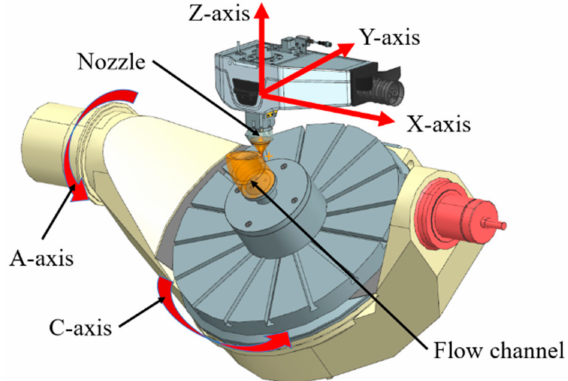
Figure 5. Configuration of the flow channel and major components in a five-axis DED machine